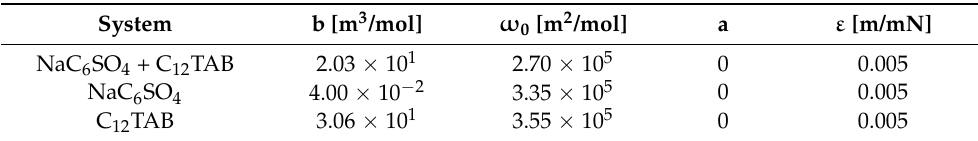
Figure 6. Equilibrium interfacial tension measured by profile analysis tensiometry (PAT) at the solution/hexane interface as a function of the total bulk concentration c of the mixtures ( (cid:7) ) NaC 6 SO 4 + C 12 TAB and the individual surfactant ( • ) C 12 TAB. The solid lines are the fitting results for a Frumkin adsorption model given by Equations (1)–(3); the dashed line ( --- ) was obtained by calculations using the parameters for NaC 6 SO 4 listed in Table 6 and almost coincide with the values estimated by Traube’s rule. Table 6. Parameter values obtained by fitting the Frumkin adsorption model Equations (1)–(3) to the experimental data of Figure 6.